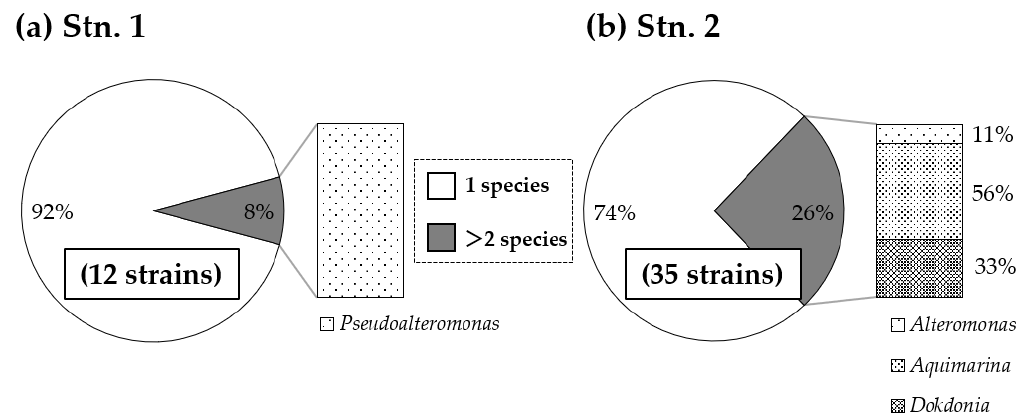
Figure 7. The growth-limiting activity ranges of GLB against all five harmful algal species ( A. catenella , C. antiqua , H. akashiwo , H. circularisquama , and K. mikimotoi ) isolated from ( a ) Stn. 1 and ( b ) Stn. 2. It includes all GLB strains isolated from seawater and macroalgal samples at each site. Total strains tested are shown in parenthesis in the lower center of the pie chart.